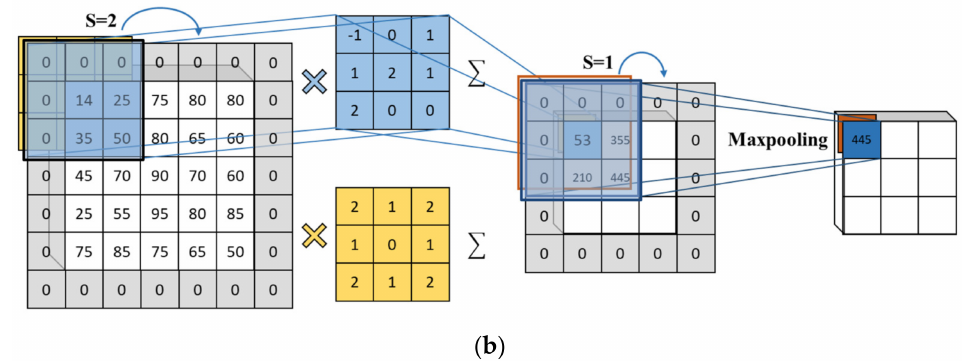
Figure 5. Operating principles of ( a ) conventional convolution and pooling layers and ( b ) novel convolution and pooling layers.